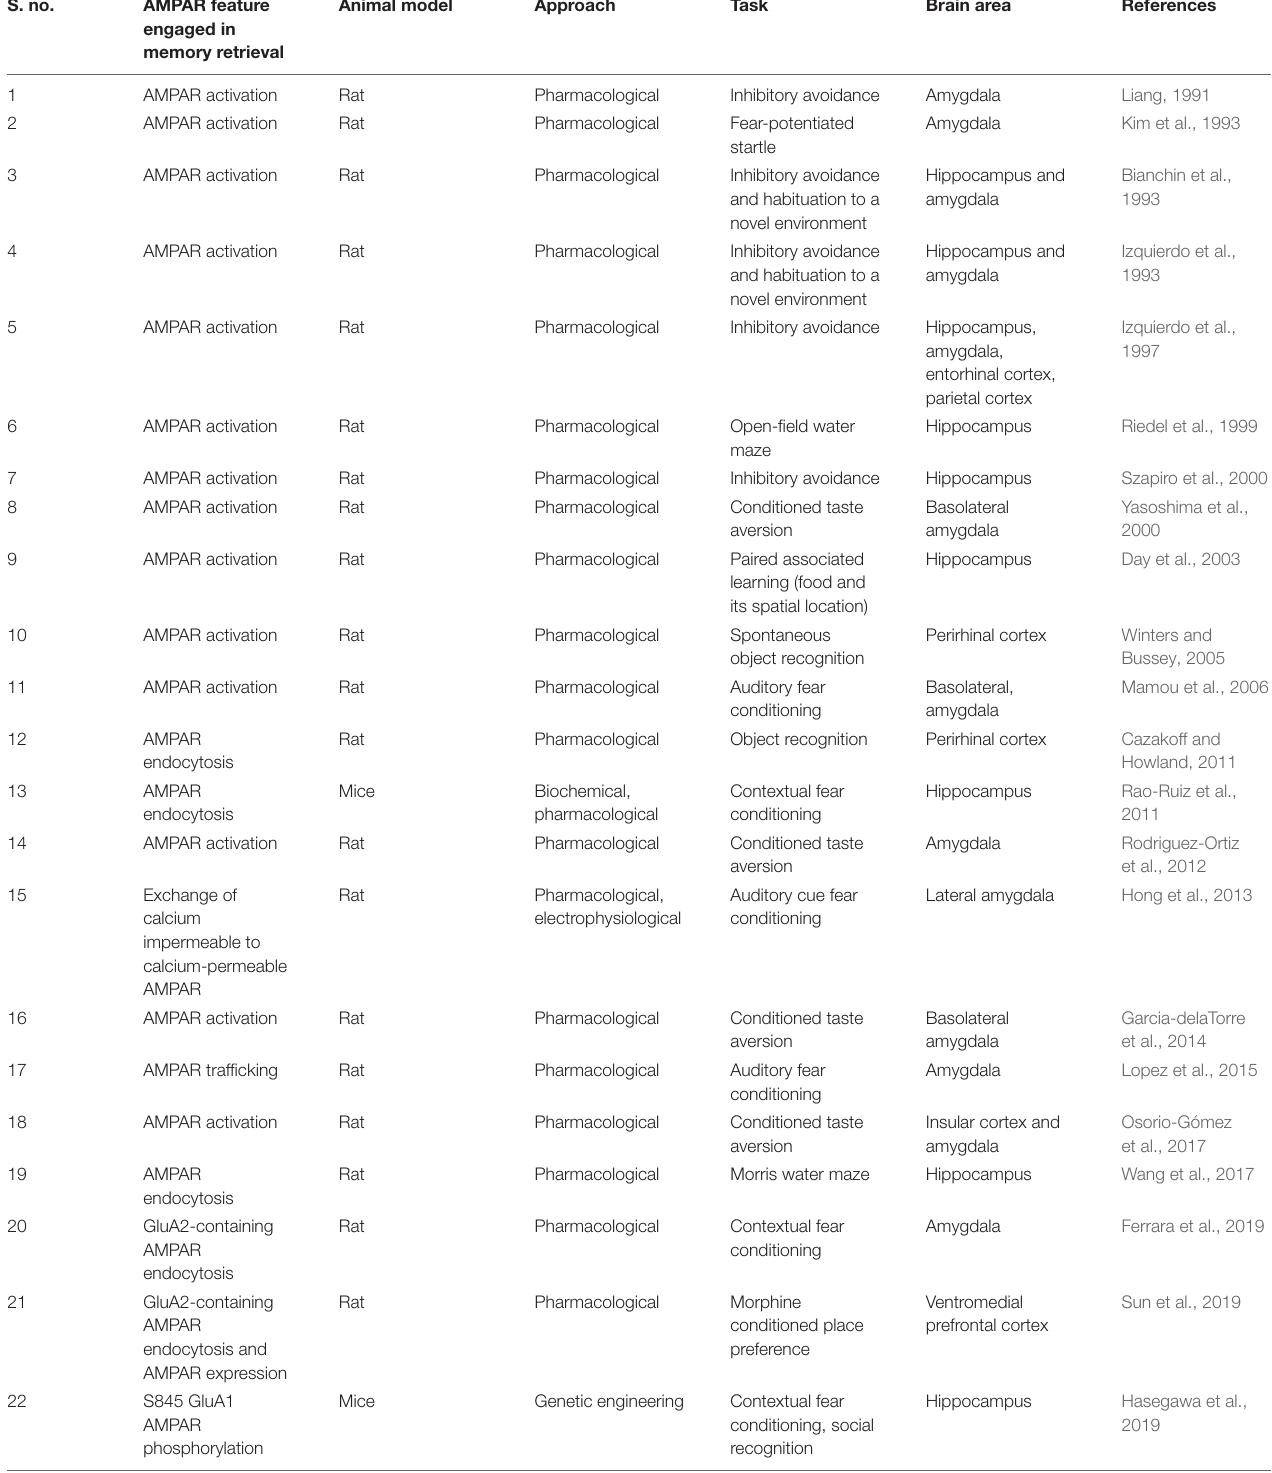
TABLE 1 | Link between AMPAR changes and memory retrieval reported in the literature. S.